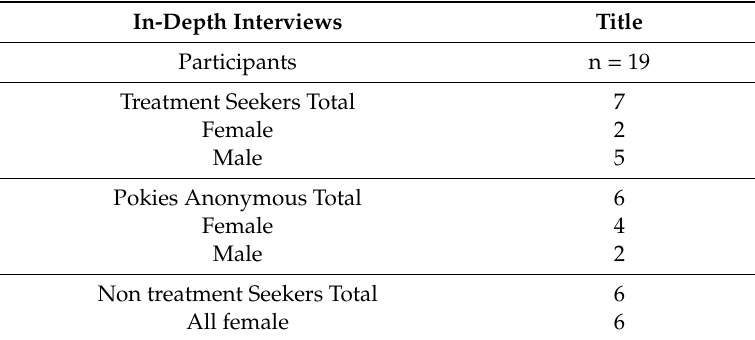
Table 2. In-depth interview